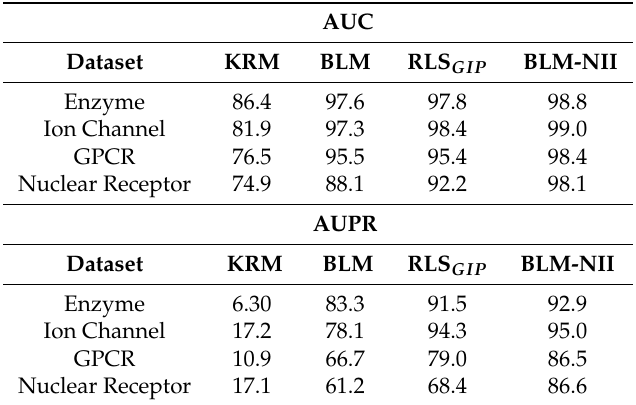
Table 2. Performance comparison of BLM-based methods [52].